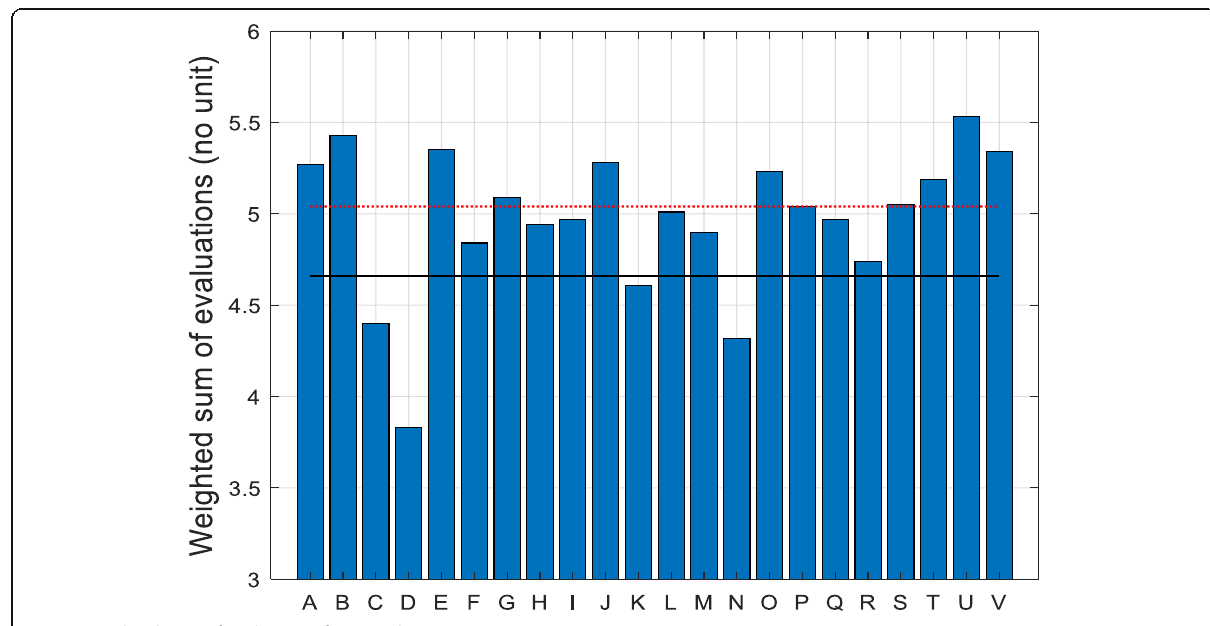
Fig. 4 Weighted sum of evaluations from Pugh matrix